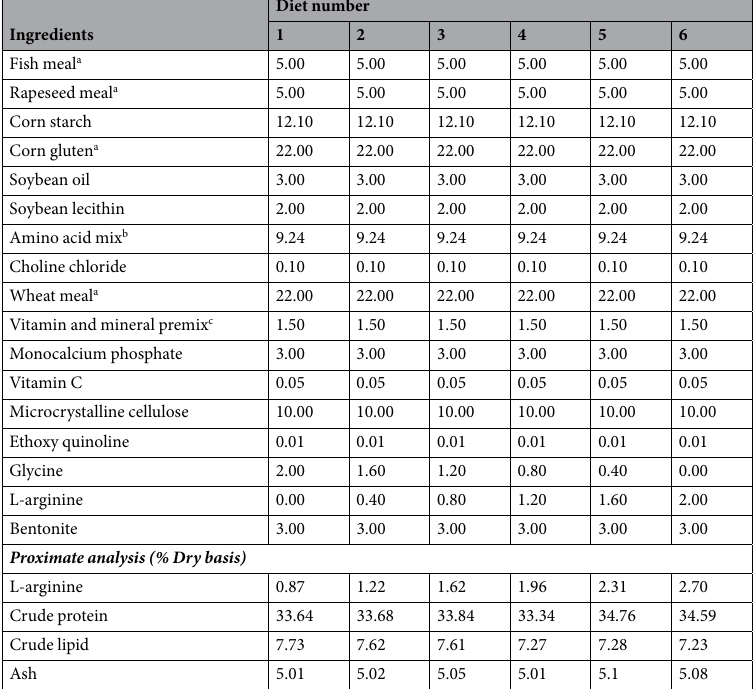
Table 1. Formulation and proximate composition of the experimental diets (% dry matter). a Rapeseed meal obtained from Wuxi Tongwei feedstuffs Co., Ltd, Wuxi, China, crude protein 37.5%, crude lipid 1.4%; Corn gluten, obtained from Wuxi Tongwei feedstuffs Co., Ltd, Wuxi, China, crude protein 55.9%, crude lipid 3.3%; fish meal, obtained from Wuxi Tongwei feedstuffs Co., Ltd, Wuxi, China, crude protein 61.4%, crude lipid 9.3%; wheat meal obtained from Wuxi Tongwei feedstuffs Co., Ltd, Wuxi, China, crude protein 11.8%, crude lipid 1.2%. b Amino acid premix (g/100 g diet): L-histidine, 0.22; L-isoleucine, 0.50; L-lysine, 1.57; L -phenylalanine, 0.2; L-threonine, 0.53; L-valine, 0.44; L-aspartic acid, 1.18; serine, 0.31; glycine, 1.55; alanine; 0.39; L -tyrosine,0.07; tryptophan, 0.12; glumatic acid, 0.14; proline 0.10. Amino acids obtained fromFeeer